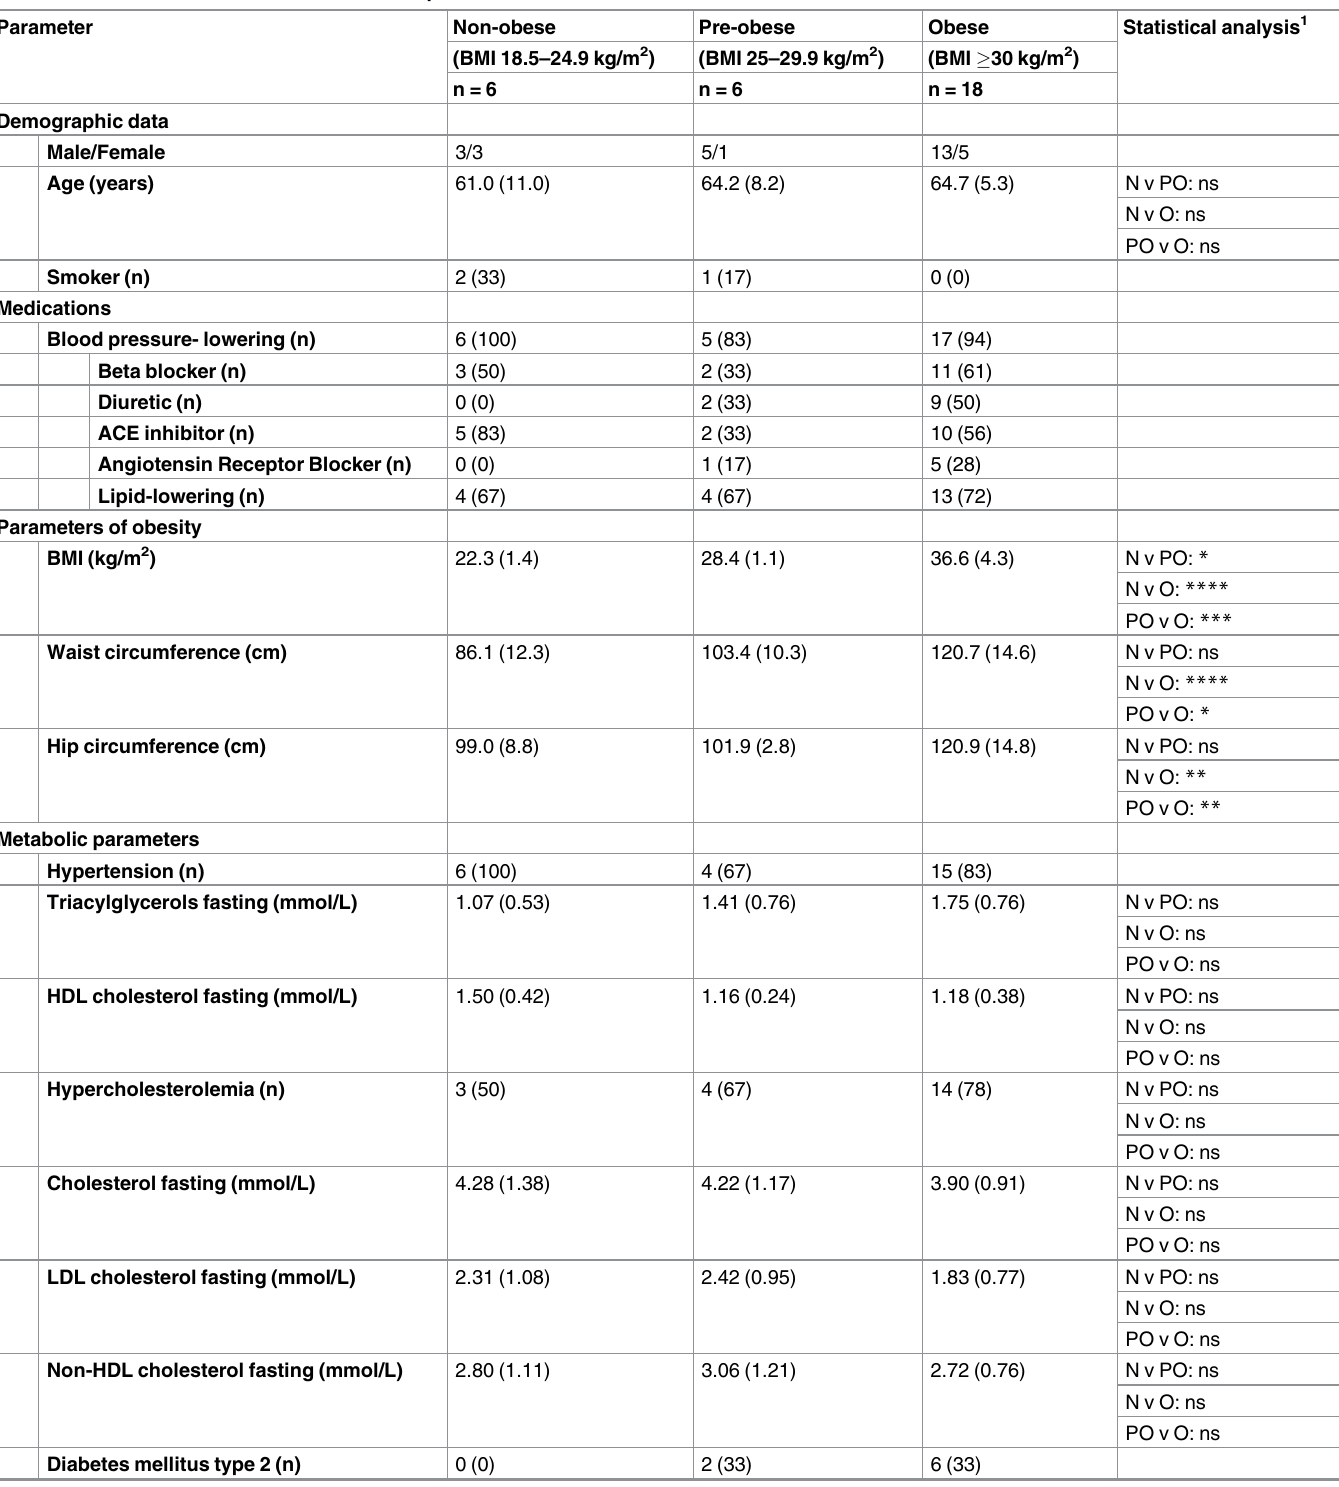
Table 3. Patient characteristics and metabolic